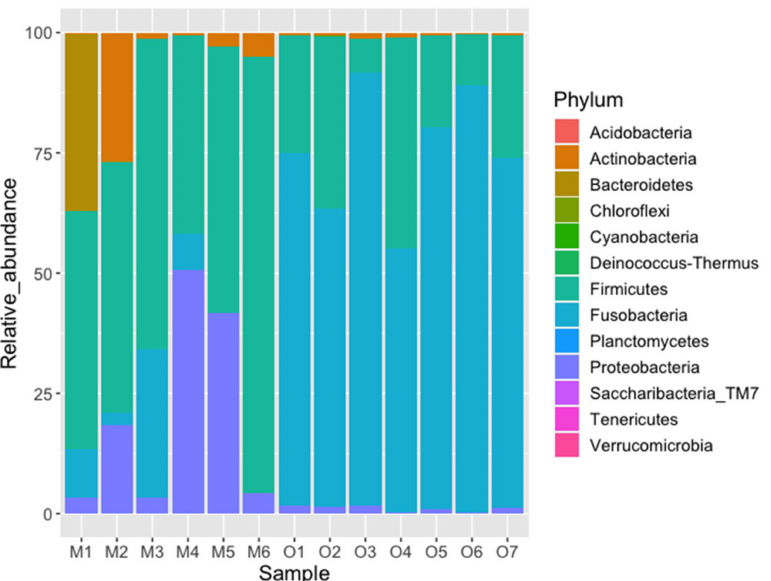
Figure 3. Relative abundance (%) of fecal bacterial taxa (phylum level) from two populations of Mexican wolves ( Canis lupus baileyi ) in Michilia (M, 23 ◦ N) and Ocotal (O, 19 ◦ N), Mexico.